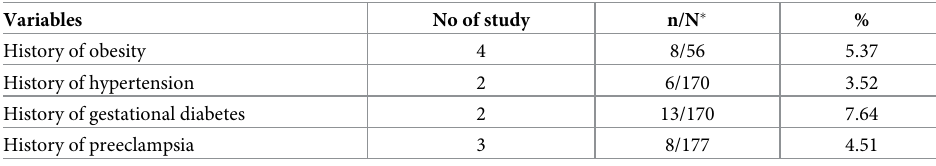
� n: number of patients with any variable, N: Total number of mothers with